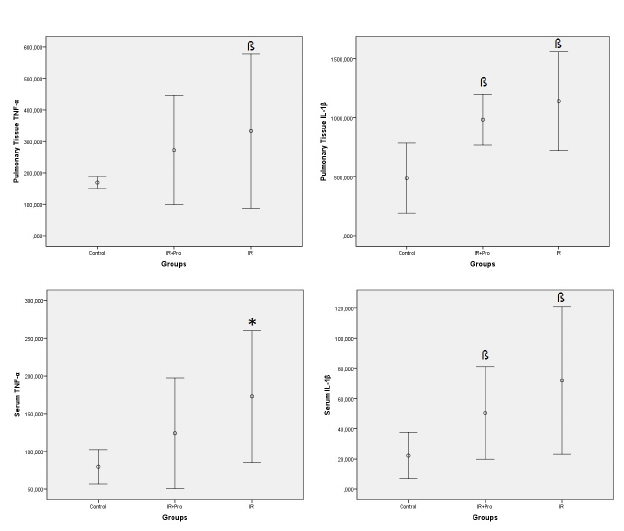
Fig. 2 - Results of serum and lung tissue cytokine levels. *P<0.05 compared to the control and IR+Pro groups. ß P<0.05